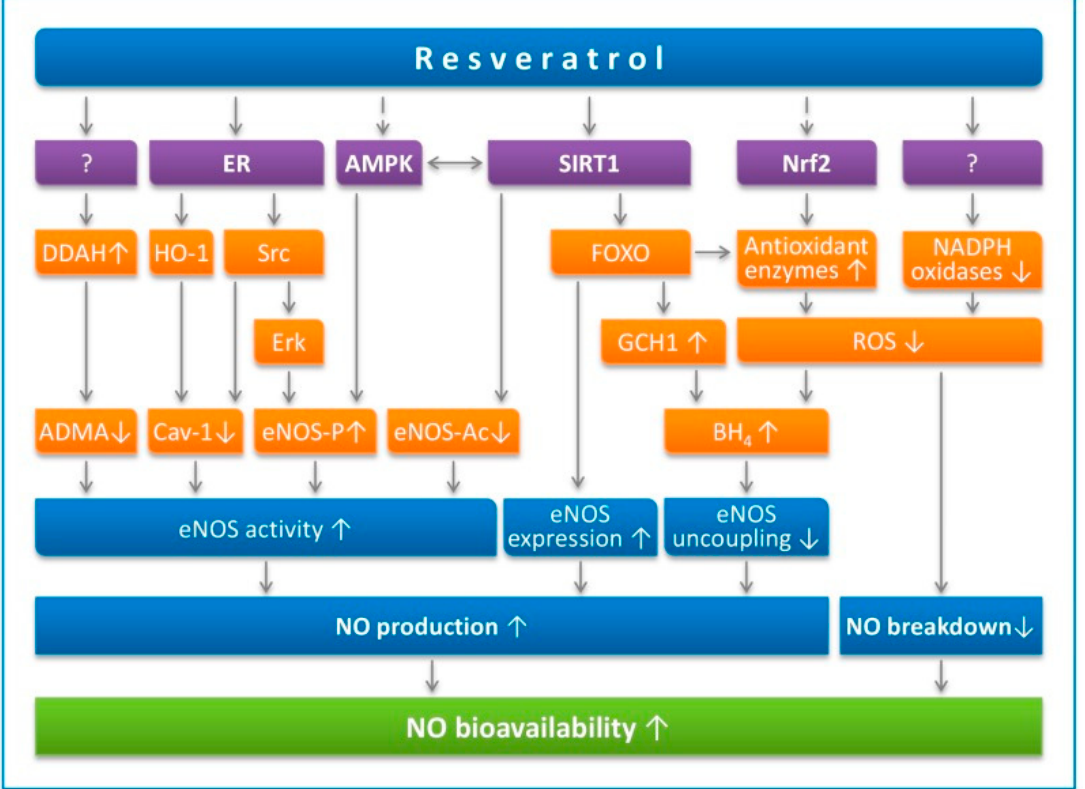
Figure 1. Resveratrol enhances NO production and prevents NO breakdown. Resveratrol activates SIRT1 directly (in a substrate-dependent manner) or indirectly (by either inhibiting phosphodiesterases or enhancing the e ff ect of lamin A). SIRT1 stimulates endothelial NO synthase (eNOS) activity through deacetylation, enhances eNOS expression by deacetylating Forkhead box O (FOXO) transcription factors, and prevents eNOS uncoupling by upregulating GTP cyclohydrolase 1 (GCH1), the rate-limiting enzyme in tetrahydrobiopterin (BH4) biosynthesis. AMP-activated protein kinase (AMPK) and nuclear factor-erythroid-derived 2-related factor-2 (Nrf2) are indirect targets of resveratrol. AMPK phosphorylates eNOS at serine 1177. eNOS can also be phosphorylated by Erk1 / 2, which is stimulated by a pathway involving estrogen receptors (ER) and the tyrosine kinase Src. Caveolin-1